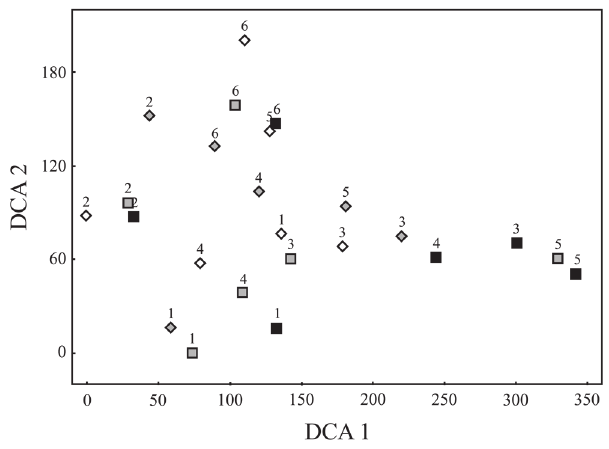
Fig. 4. Ordination of the samples of the upper Paraná River floodplain, through the detrended correspondence analysis (DCA), in years of short (diamond: 2000 white, 2001 gray) and moderate floods (square: 2002 gray, 2003 black). Numbers 1-6 are codes of the sampling stations (see Fig.